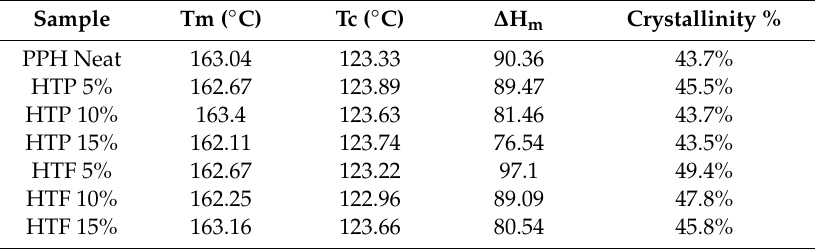
Table 5. Crystallinity index of treated fibers / PPH composites.